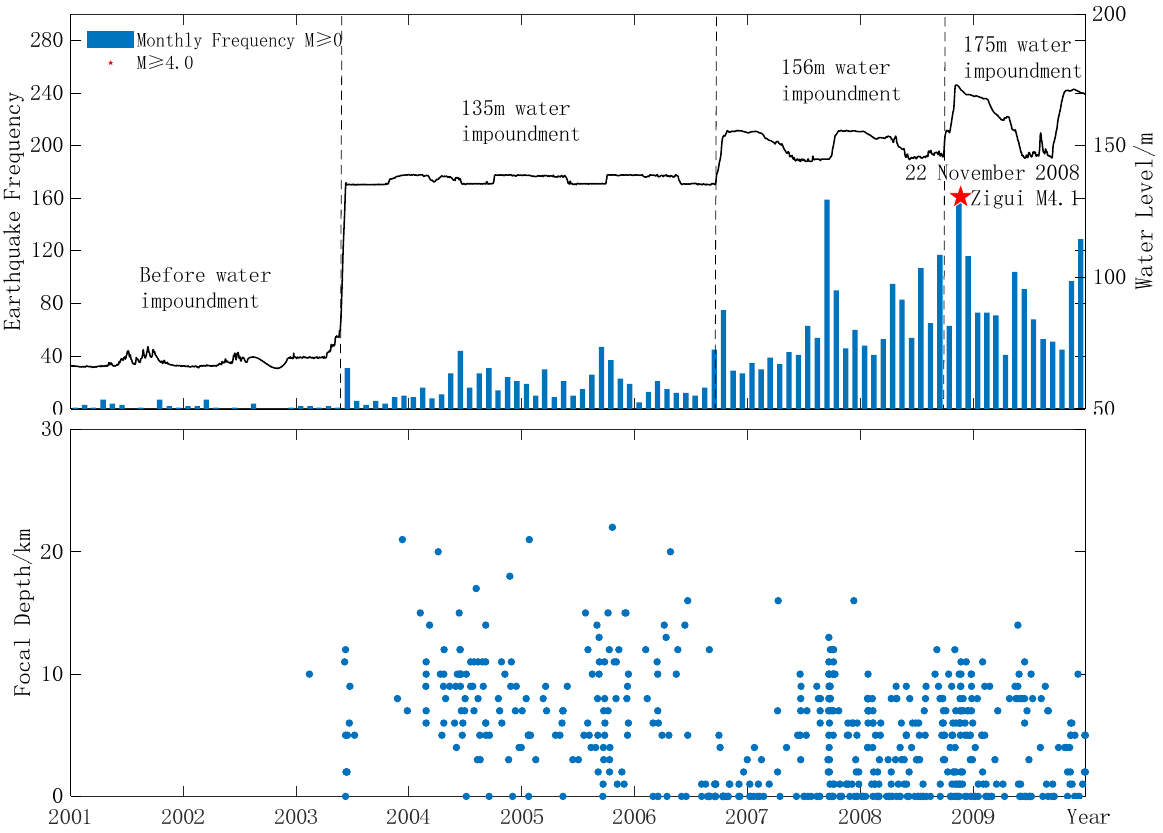
Figure 4. Reservoir water level, monthly seismic frequency, and the earthquakes above M4.0 during the impounding process of the TGR (January 2001–December 2009, M ≥ 0).